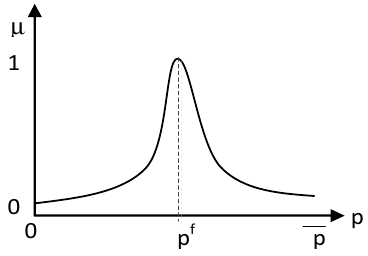
Figure 1. Membership function for the penalty cost of wind power curtailment.